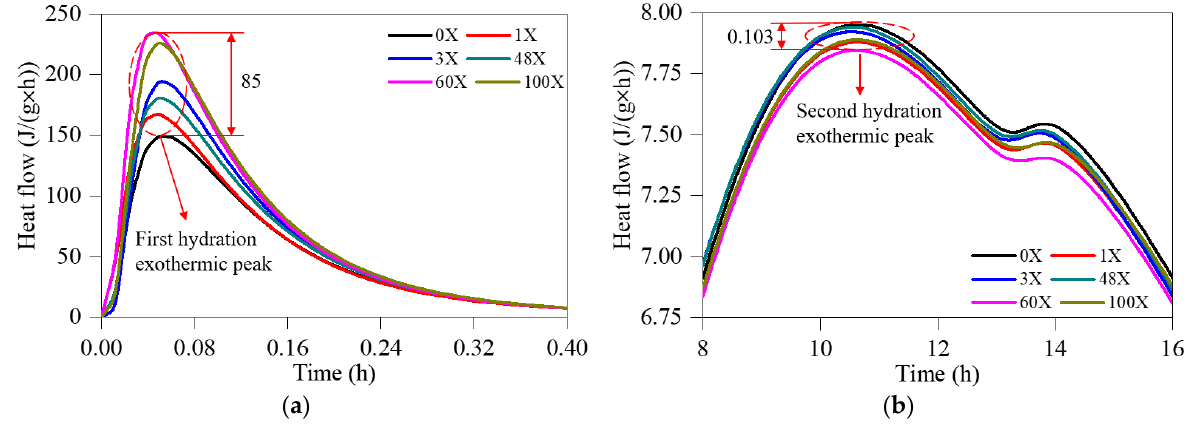
Figure 8. Hydration exothermic peak with different content of the CTF: ( a ) First hydration exothermic peak; ( b ) Second hydration exothermic peak.